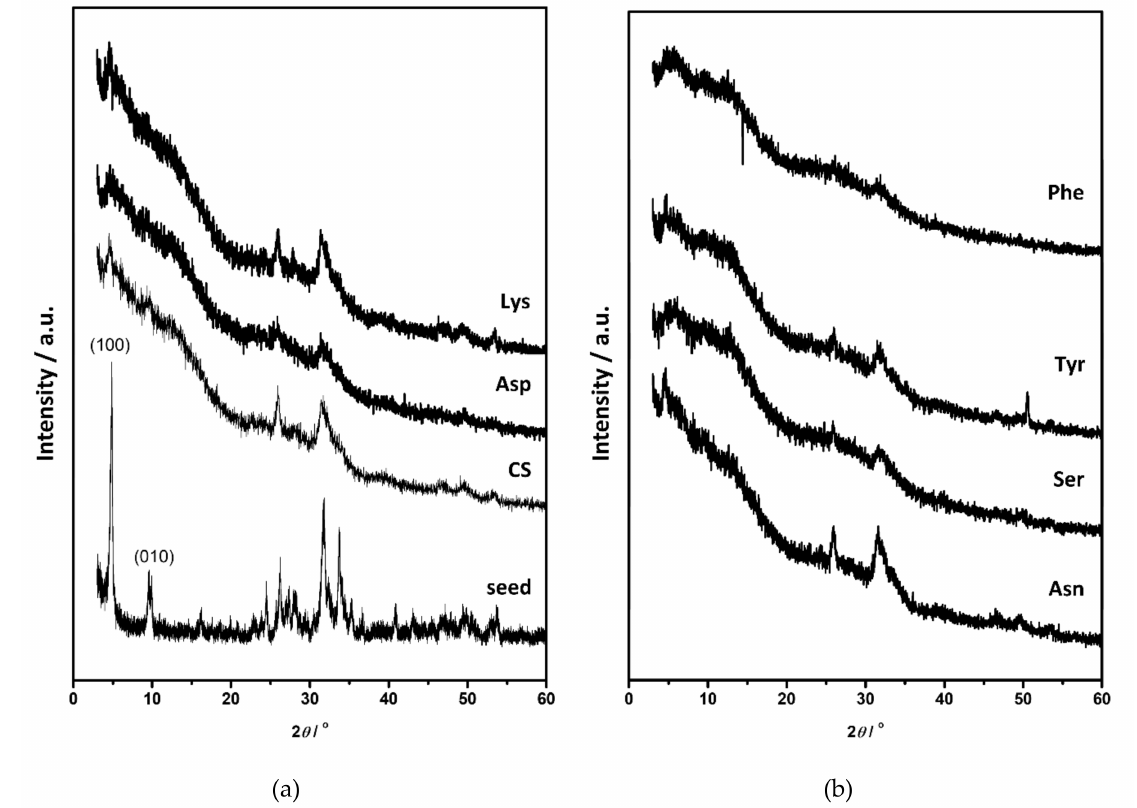
Figure3. PXRDdi ff ractogramsof( a )octacalciumphosphate(OCP)seedcrystalsandprecipitatesformed in the control system (CS) and in the presence of aspartic acid (Asp) and lysine (Lys), ( b ) precipitates obtained in the presence of asparagine (Asn), serine (Ser), tyrosine (Tyr) and phenylalanine (Phe) after 240 min aging time in the system in c( CaCl 2 ) = c (Na 2 HPO 4 ) = 4.198 mmol dm − 3 , c (NaCl) = 0.148 mol dm − 3 , m (seed OCP) = 1 mg, γ (AA) = 10 ppm, except γ (Phe) = 5 ppm. t = 25 ◦ C, pH initial